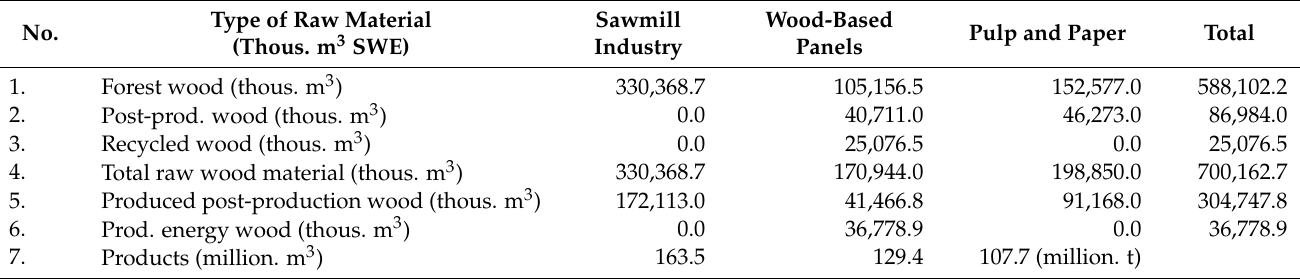
Table 1. Summary of the amount of raw material consumed by the woodworking industries in 2017 in